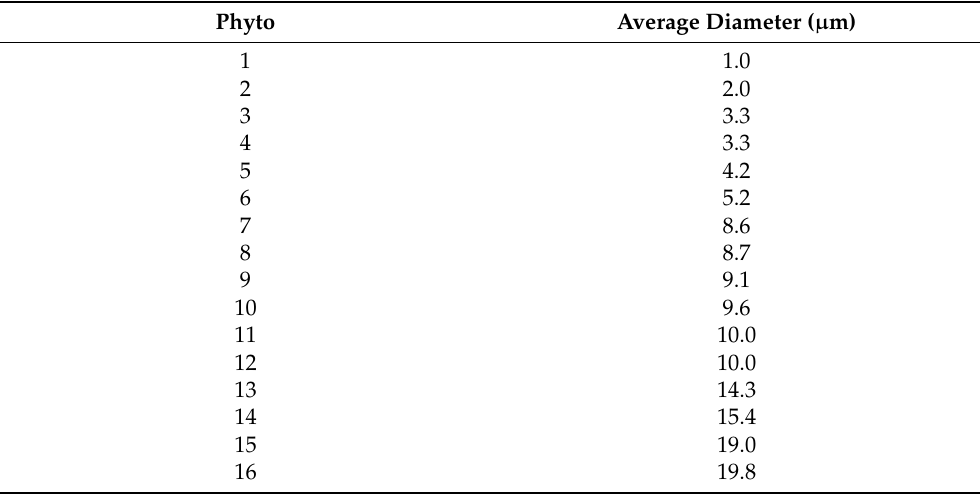
Table 2. Average diameters of phytoplankton populations. Based on their average cell diameter, Phyto 1 and 2 were defined as picophytoplankton and Phyto 3–17 as nanophytoplankton. Phyto 4, 6, and 8 were defined as cryptophytes, based on their orange autofluorescence. Phyto Average Diameter ( µ m) 1